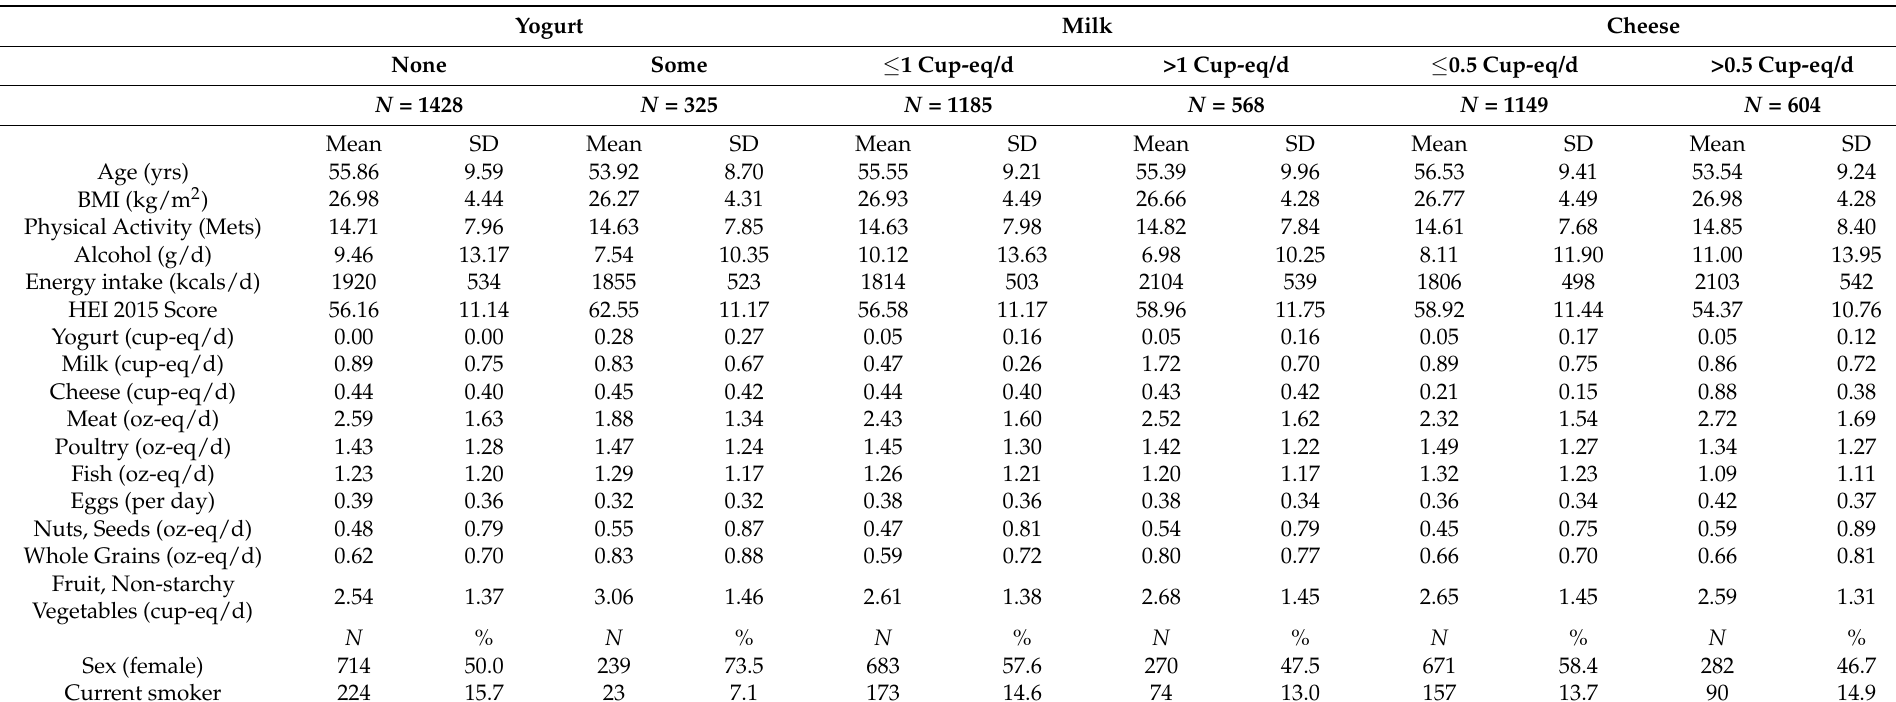
Table 1. Baseline subject characteristics according to category of dairy food intake. Yogurt Milk Cheese None